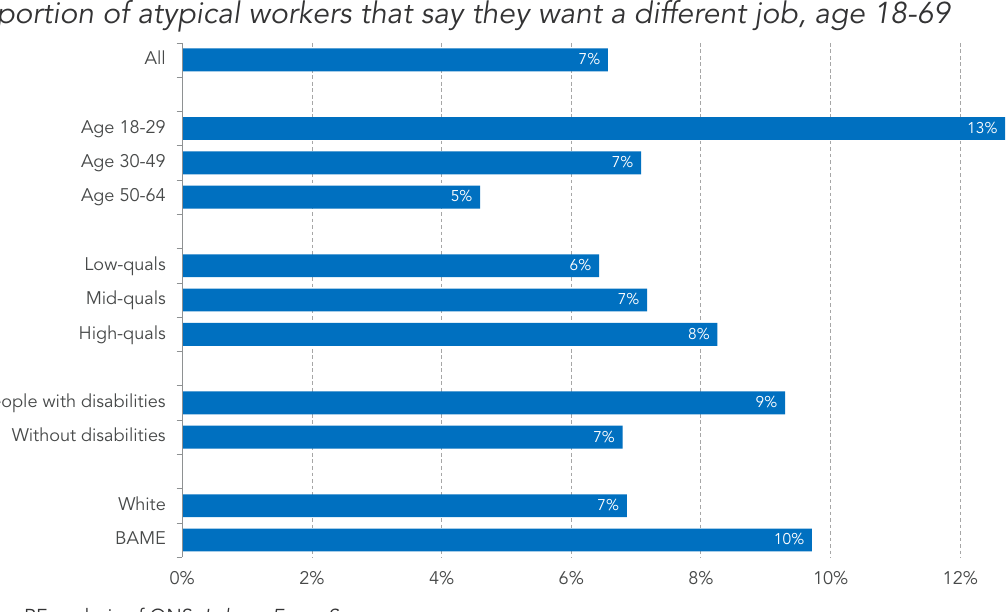
Figure 38: Younger atypical workers are more likely to express dissatisfaction Proportion of atypical workers that say they want a different job, age 18-69